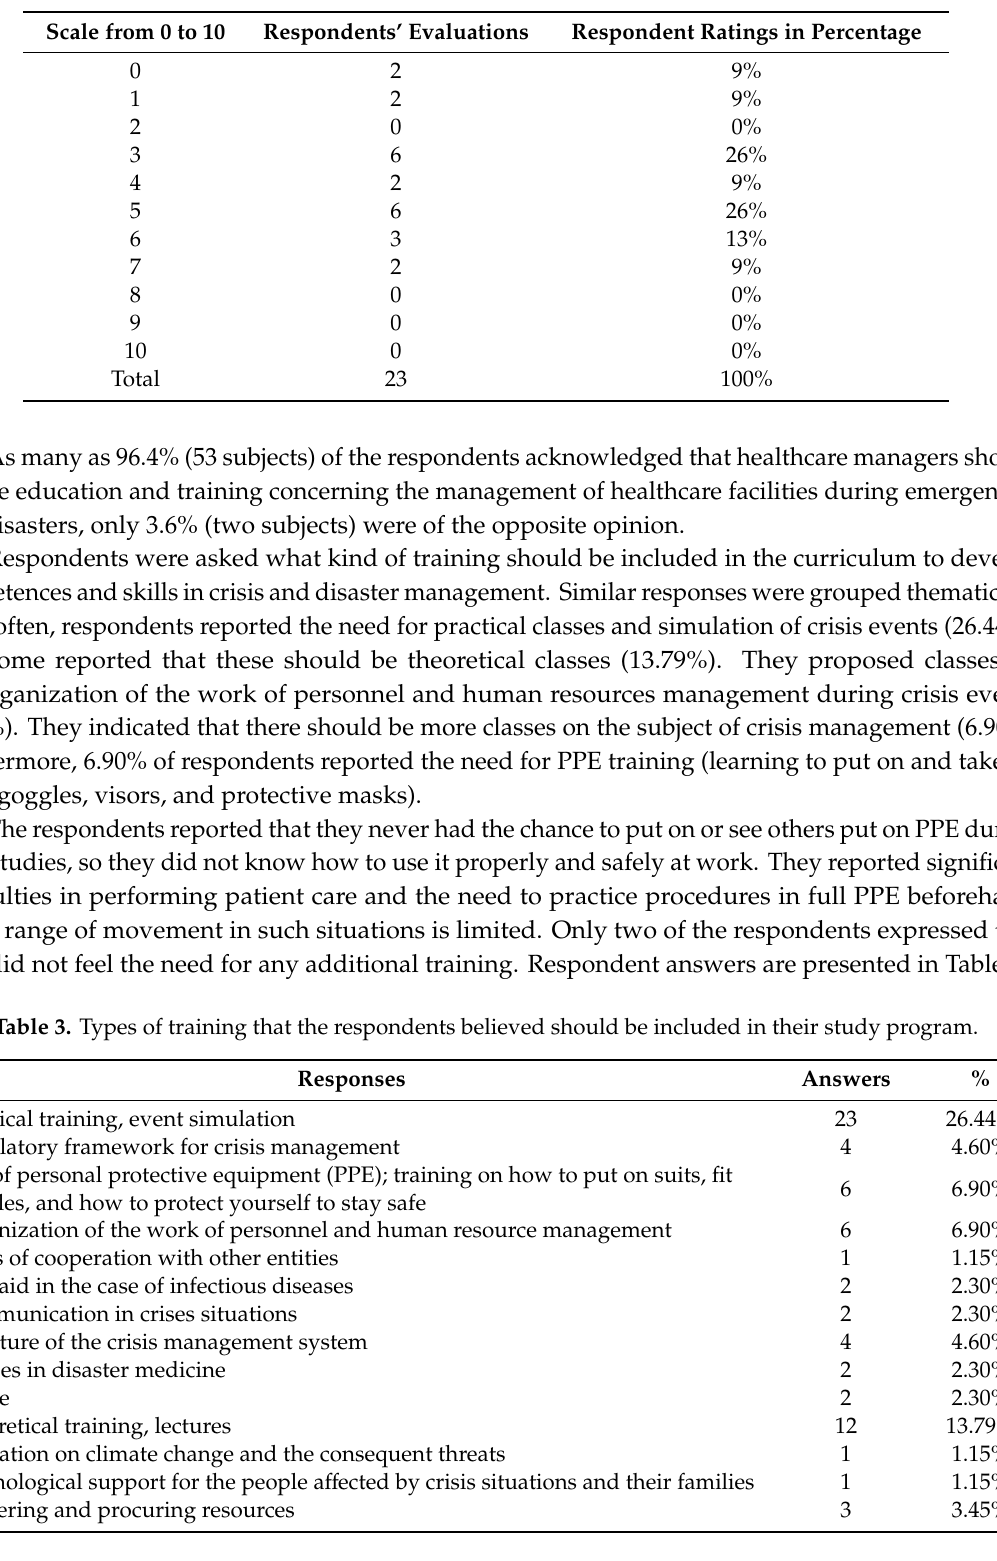
Table 2. Subjective evaluations of the respondents of the preparedness of healthcare facilities in which they work for the COVID-19 pandemic.